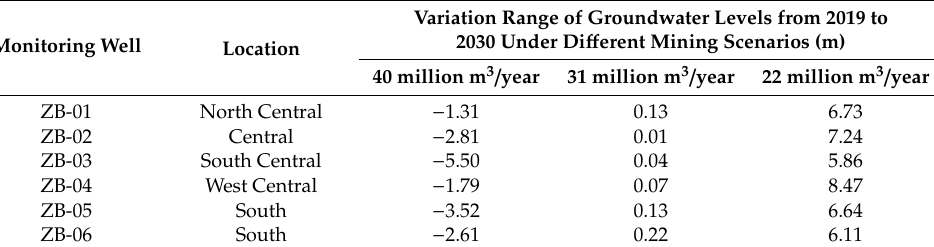
Table 4. Analysis of variation for groundwater level from 2019 to 2030 di ff erent mining scenarios.